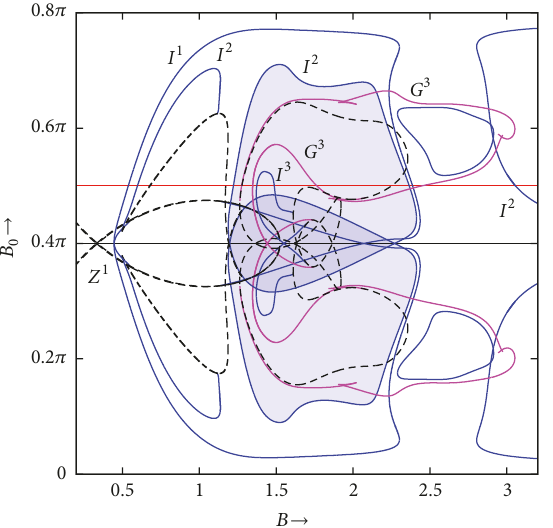
Figure 6: Bifurcation diagram of system (3) in 𝐵 - 𝐵 0 plane with 𝑓(𝑦) = 𝑓 (𝑦) and parameters (20), 𝐵 ∈ (0.2, 3.2) , and 𝐵 2